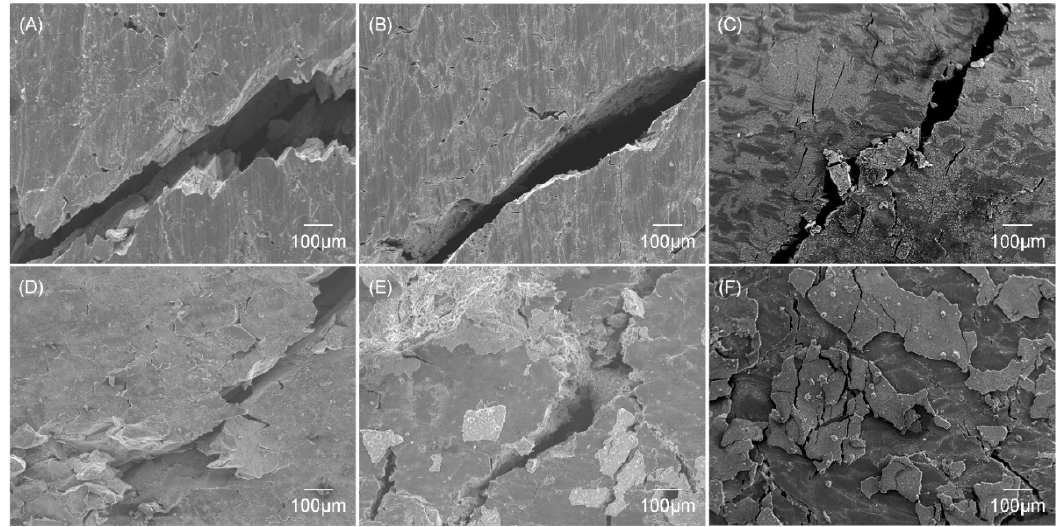
Figure 10. SEM images of fracture surface after compression tests for non-immersed samples of the ( A ) sintered Mg, ( B ) Mg/10% β -TCP, and ( C ) Mg/20% β -TCP, and samples of the ( D ) sintered Mg after 1 day immersion, ( E ) Mg/10% β -TCP after 9 days immersion, and ( F ) Mg/20% β -TCP after 6 days